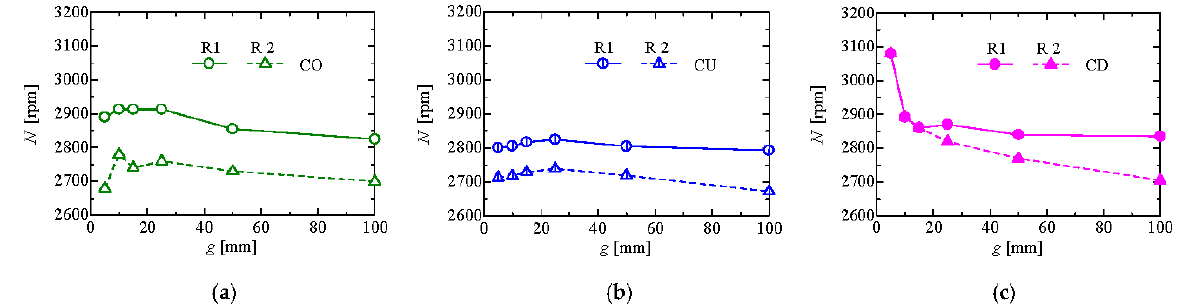
Figure 8. Variation in the rotational speed along with the gap between the two rotors: ( a ) Co-Rotating (CO); ( b ) Counter-Up (CU); ( c ) Counter-Down (CD).